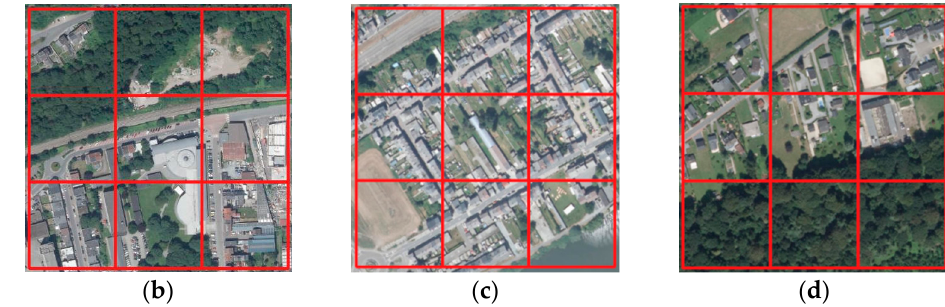
Figure 5. ( a ) Seraing; ( b ) Jemeppe/Meuse; ( c ) Engis; ( d ) Boncelles (Service Public de Wallonie, Orthophotos 2018—Service de visualisation REST. Visualization with QGIS V3.16.7).